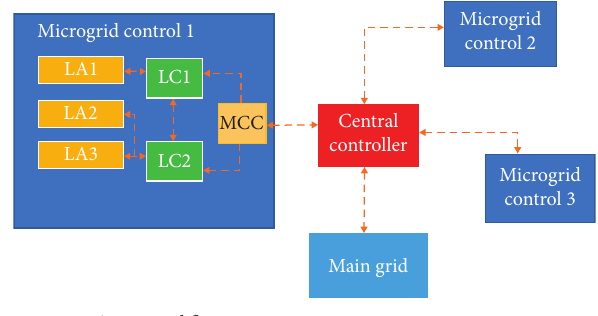
Figure 3: Hierarchical control architecture. MCC coordinates the actions of LCs with a main grid.